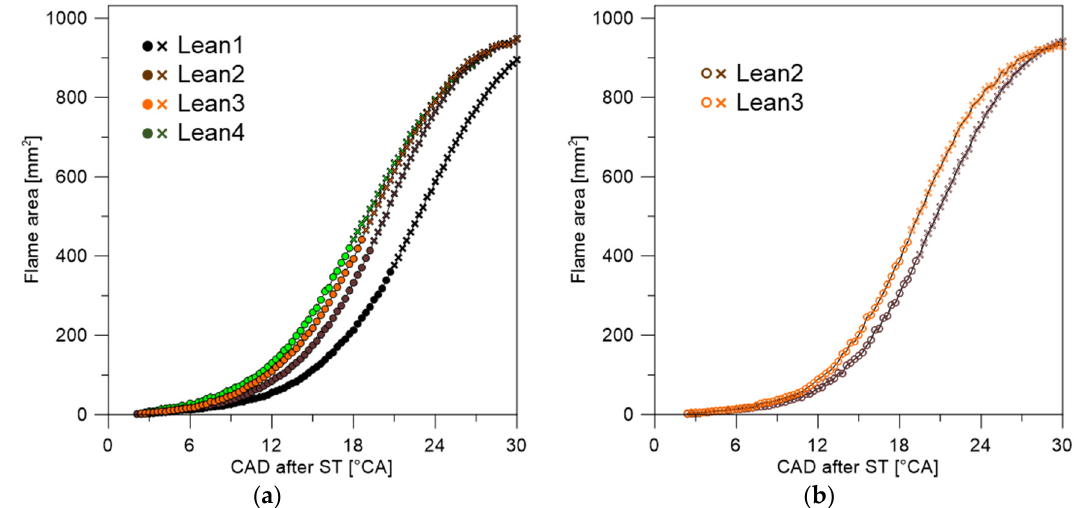
Figure 9. Flame area for lean conditions, gasoline ( a ) and E30 ( b ), at different spark advances. Data points corresponding to the CADs where the flame front has approached the limits of the field of view are represented with crosses.